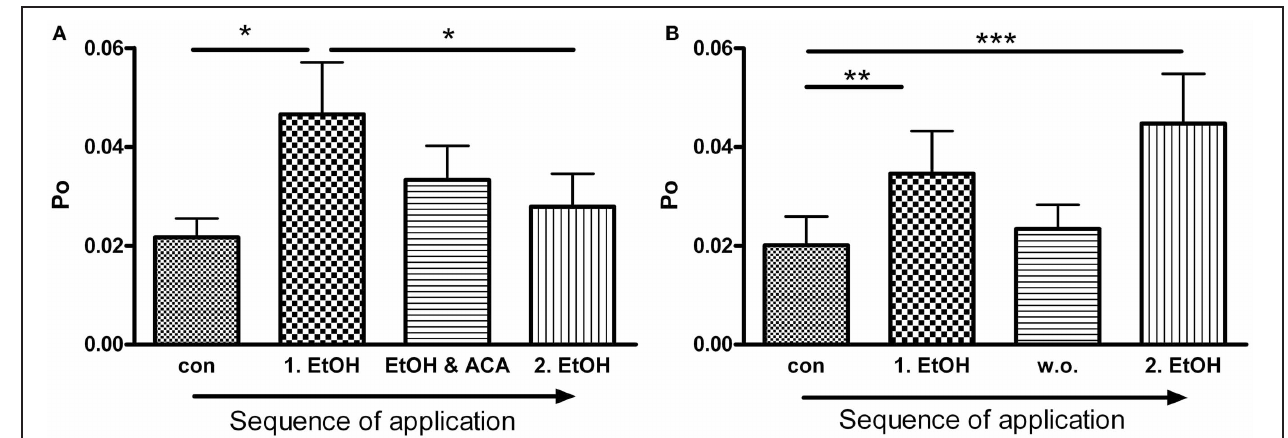
FIGURE 4 | ACA inhibits further EtOH action: (A) BK channel open probability ( Po ) was significantly increased by the first EtOH application. The following simultaneous treatment with ACA and EtOH reduced the EtOH induced increment and prevented activation by a 2 nd separate EtOH (2.EtOH) application ( n = 11, con vs. 1.EtOH ∗ p < 0 . 05, 1.EtOH vs. 2.EtOH ∗ p < 0 . 05,